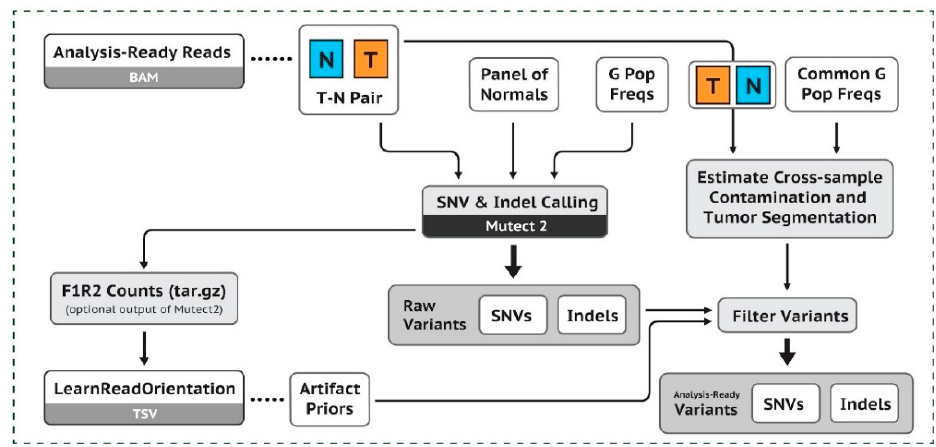
Figure 1. Presentation of the Workflow GAKT (https://gatk.broadinstitute.org/hc/en-us/articles/360035894731-Somatic-short-variant-discovery-SN Vs-Indels-; accessed on 20 May 2021 ).